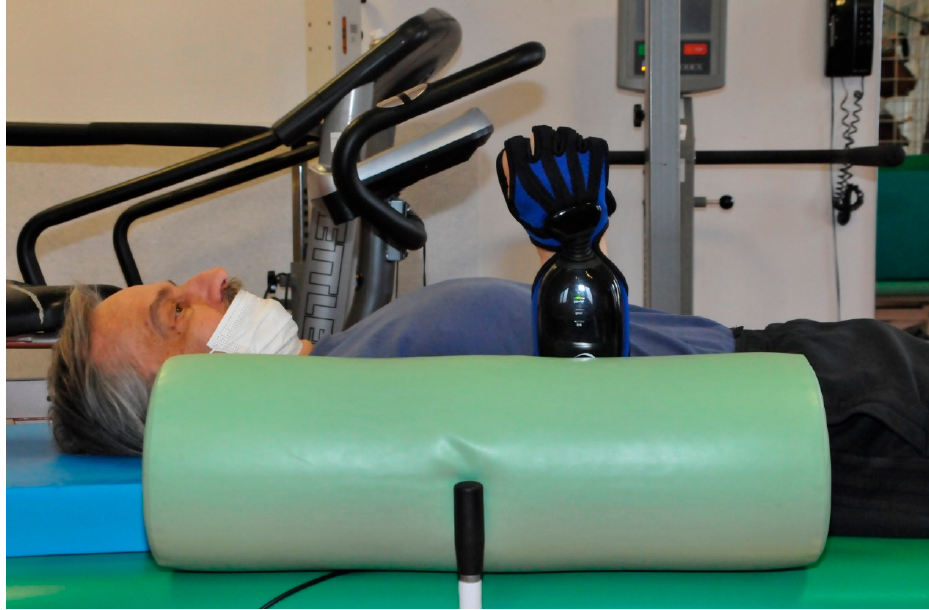
Figure 3. Passive stabilization of the trunk and upper limb (stable position).